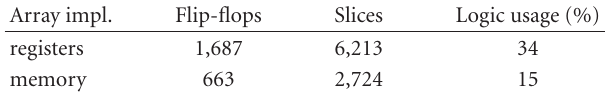
Table 3: Comparison between array implementations for